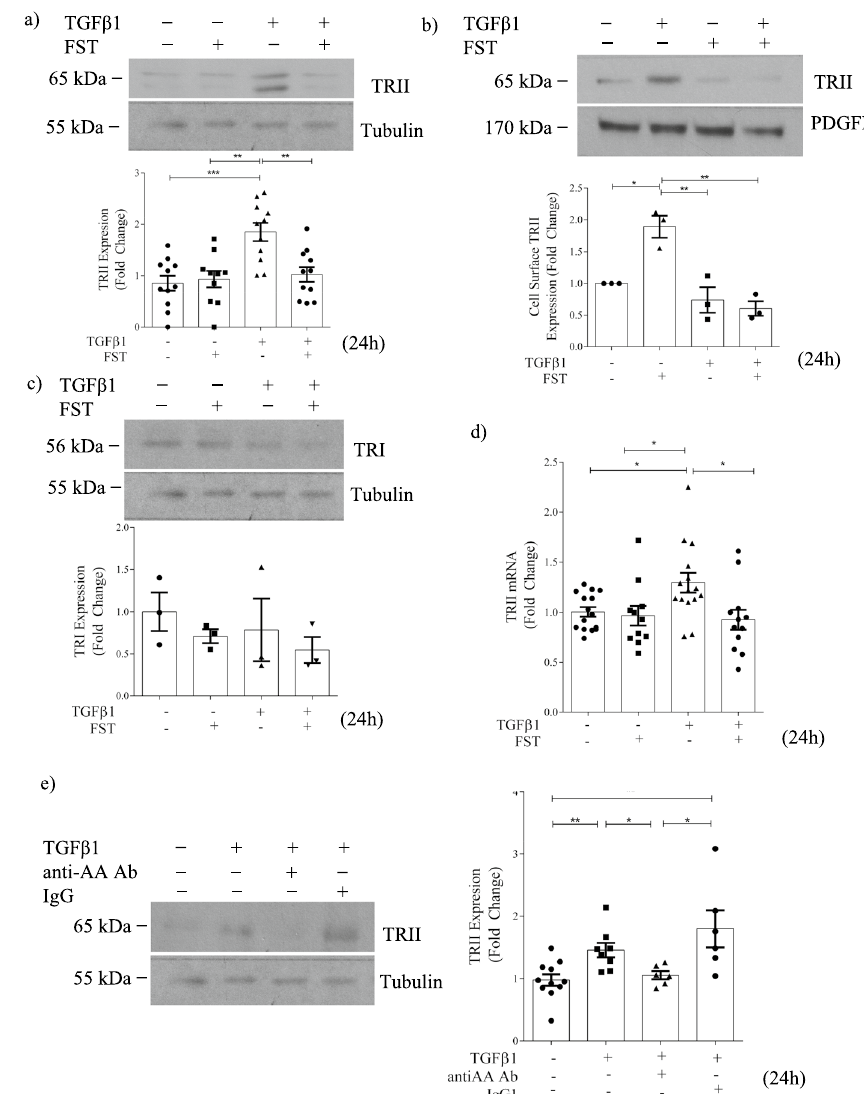
Fig. 3 Activins facilitate TGFβ1 receptor type II upregulation in response to TGFβ1 in MC. a Follistatin (FST) inhibits the TGFβ1-induced increase in TRII expression at 24 h in whole cell lysate (n The TGFβ1-induced increase in cell surface TRII was diminished by follistatin at 24 h (n in response to either TGFβ1 or follistatin were seen with TRI (n transcript was also diminished by follistatin at 24 h (n reduced with an actA neutralizing antibody